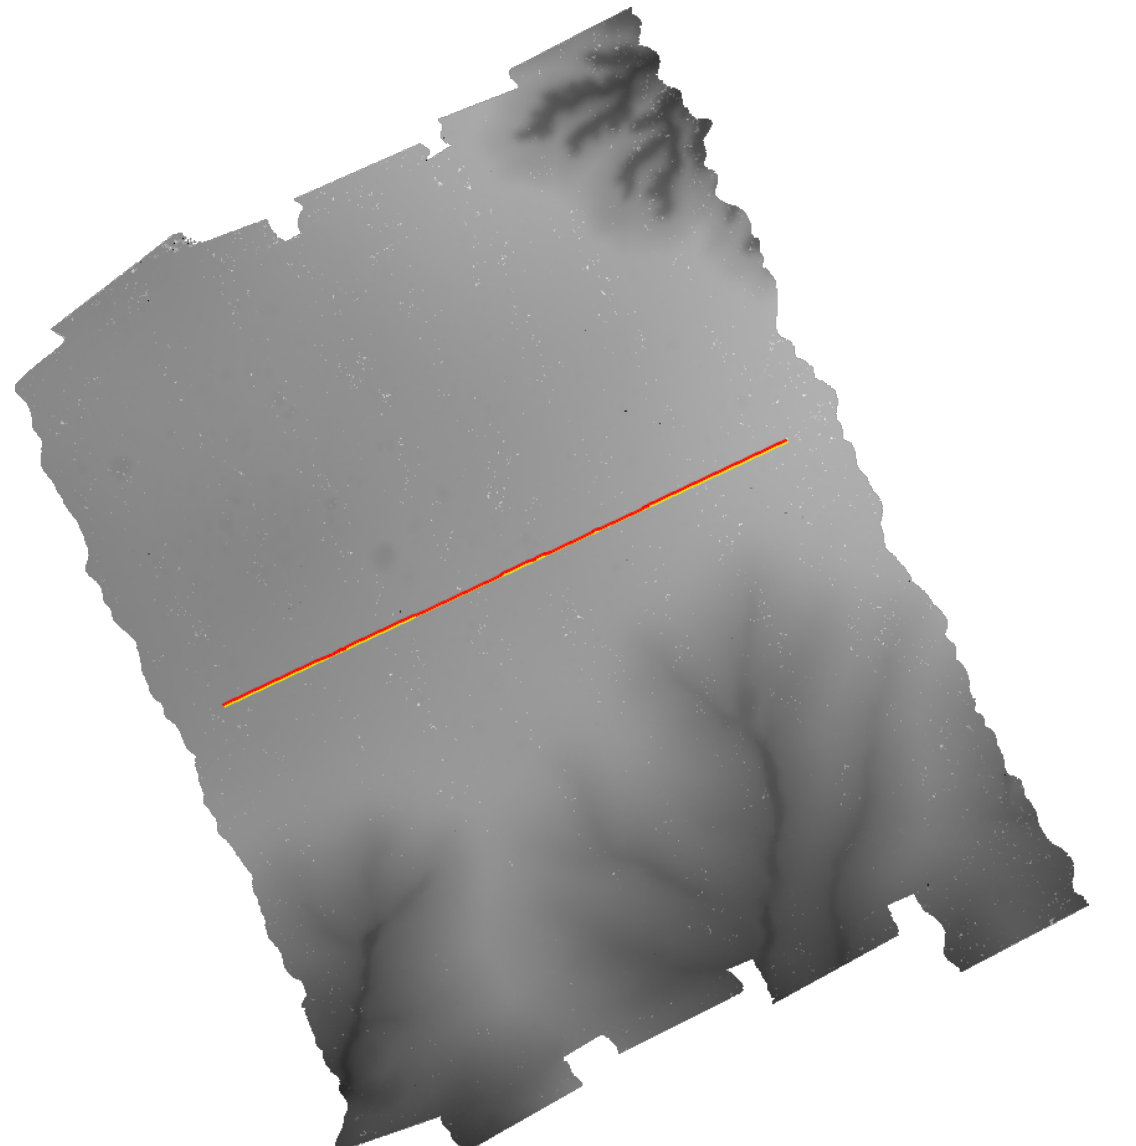
Figure 24. Trajectory in yellow on combined intensity, surface and terrain (joint), circular bin, experi- ment. Corresponding estimated positions are drawn in red. Drawn over the terrain